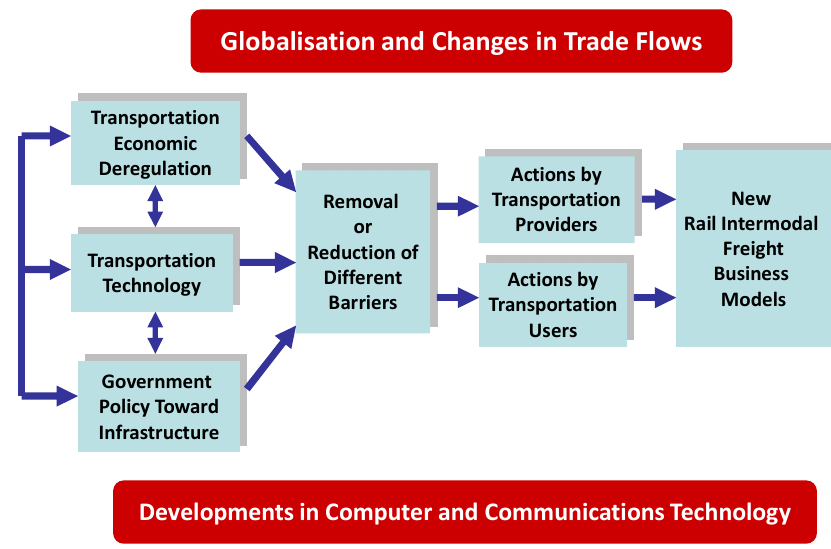
Figure 1. Conceptual Framework of Rail Intermodal Business Drivers.